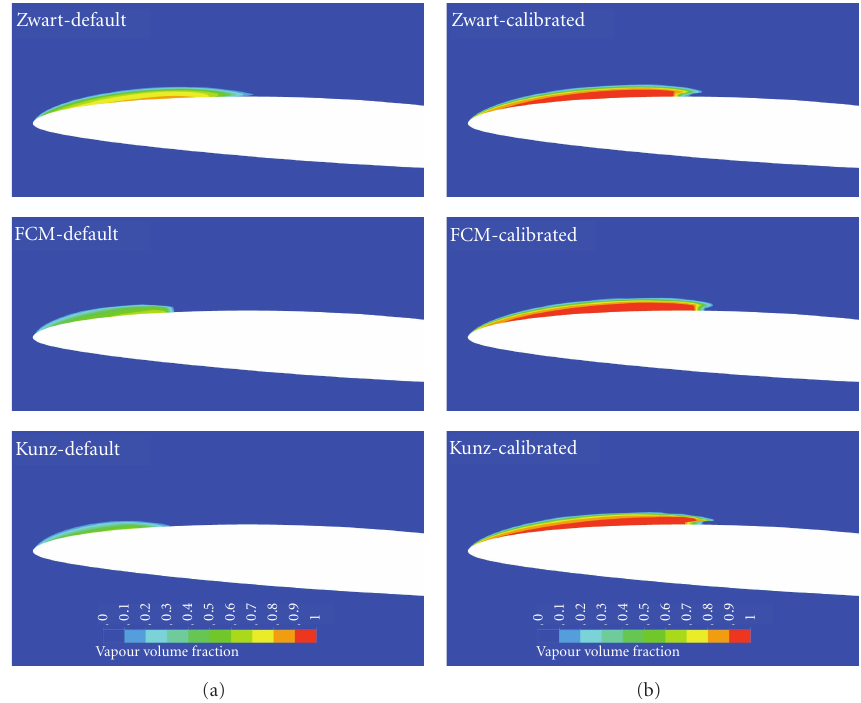
Figure 4: Sheet cavities over the NACA66(MOD) hydrofoil at AoA = 4 ◦ , Re = 2 × 10 6 , σ = 0 . 91, computed using noncalibrated (a) and calibrated (b) mass transfer models.